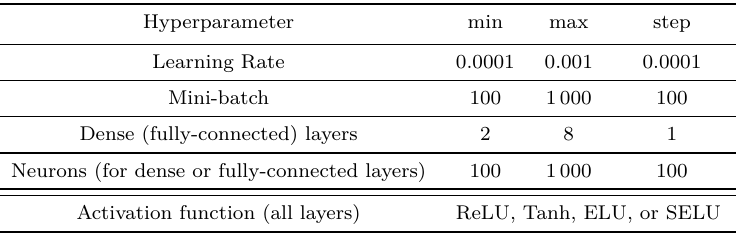
Table 2: Hyperparameter search space for multilayer